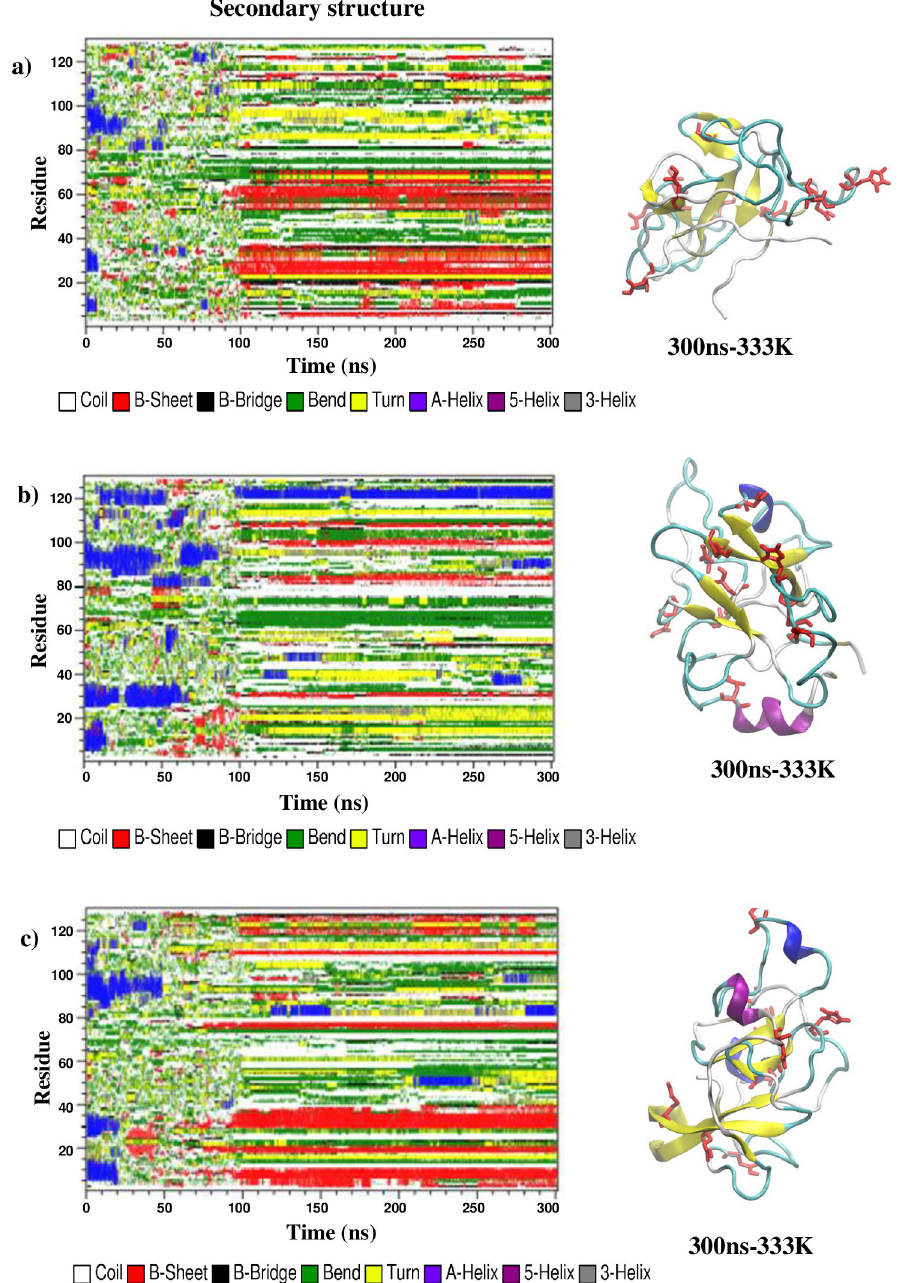
Fig 2. Time evolution of the secondary structures contents determined by the DSSP algorithm along the 450-K and 333-K simulation replicas (a) R0, (b) R1, and (c) R2 at pH 2. Snapshots of the final structure after the 333 K simulation was also given for each